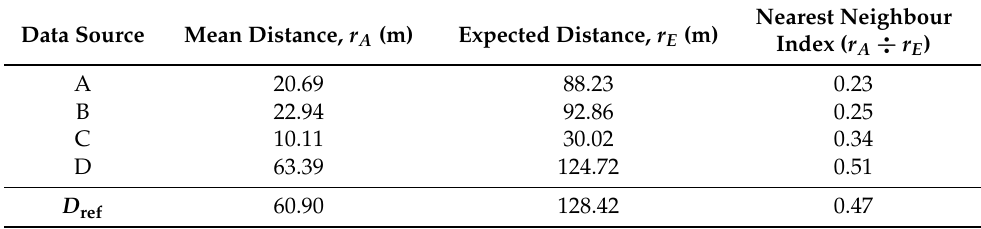
Table 3. Nearest Neighbor Index (NNi) values for four evaluated data sources ( D eval ) and reference data source ( D ref